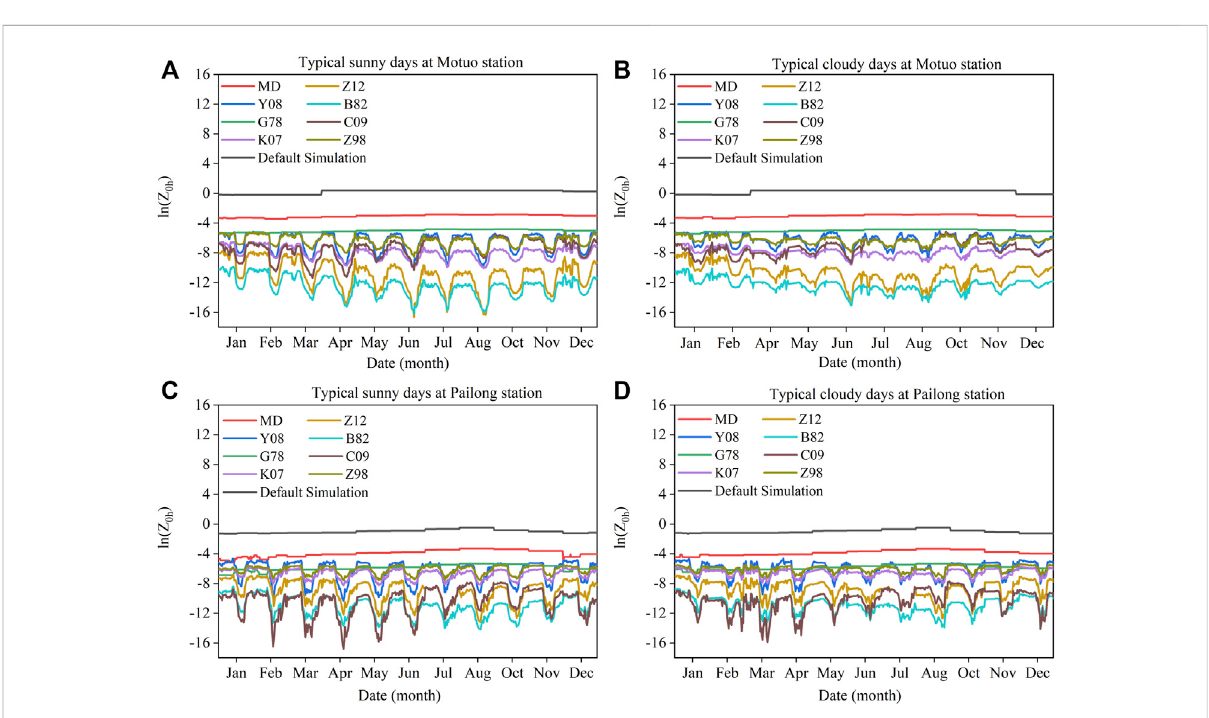
FIGURE 2 Comparison of Z 0h between the original and revised versions of CLM5.0 on typical sunny/cloudy days at Motuo and Pailong stations, the scheme that integrates MSP and MPFT referred to as MD